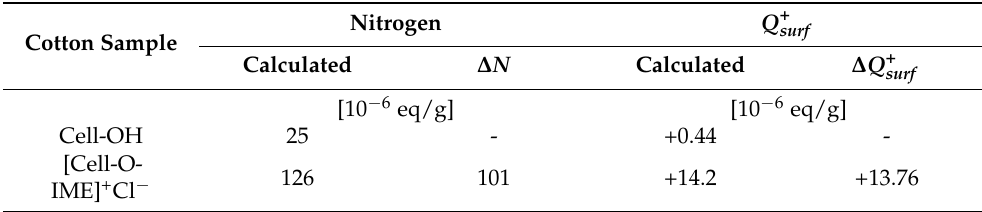
Table 4. Calculated values of nitrogen content and specific surface charge for uncationised and cationised cotton